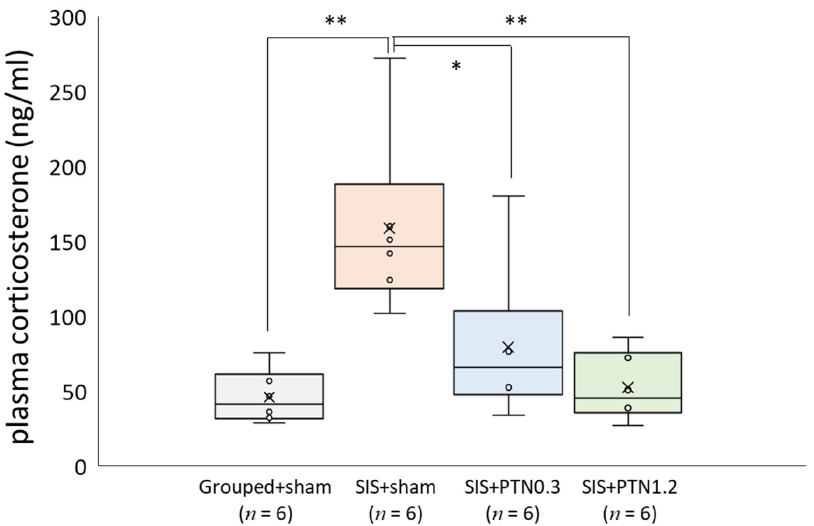
Figure 5. Plasma corticosterone level following the social isolation stress load. Increased corticos- terone level induced by social isolation stress was significantly inhibited due to PTN treatment (0.3 mm, * p < 0.05; 1.2 mm, ** p < 0.01). Horizontal lines within boxes denote median values, and x-marks denote mean values. * p < 0.05, ** p < 0.01. SIS, social isolation stress; PTN, press tack nee- dle.